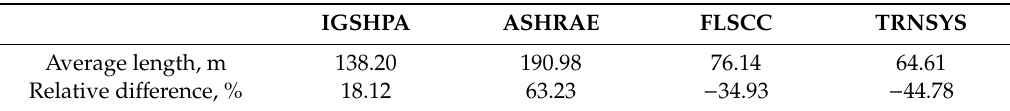
Table 5. Comparison of the average borehole design length from the four sizing